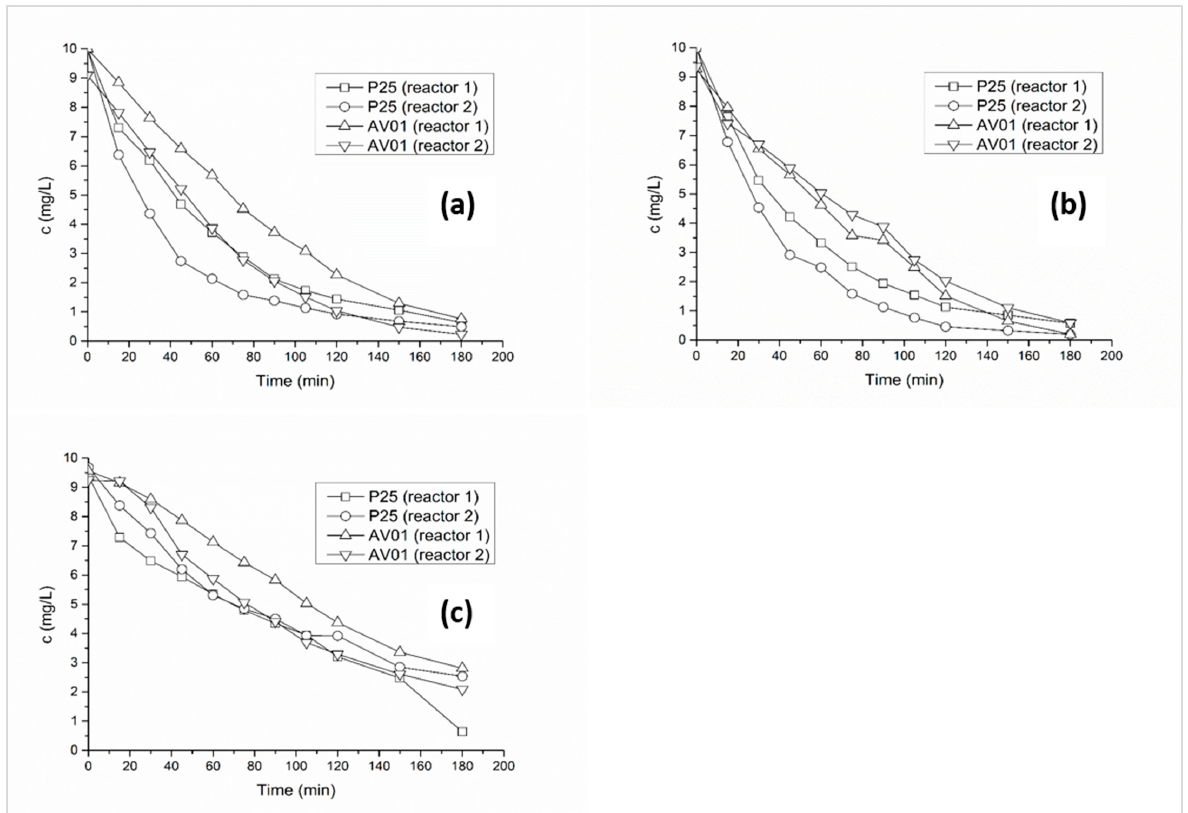
Figure 1. Variations in the concentration of herbicides during the different experimental setups of the photocatalysis process: ( a ) alachlor, ( b ) metolachlor, ( c ) acetochlor. The error bars are not included in the graphs, as the measurement error was less than 5% for all measurements. As a result, the error bars are short and smaller than the size of the markers in the plot. Adding error lines would make the graphs confusing.